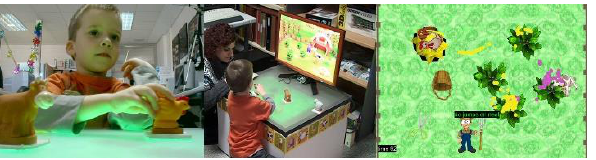
Figure 3. Three video streams synchronized for evaluation. Left, coming from a camera below the monitor for emotion analysis. Central, coming from a camera in a corner of the test room for usability analysis. Right, coming from the graphical visualization of the log files to be used for monitoring game events and feedback.